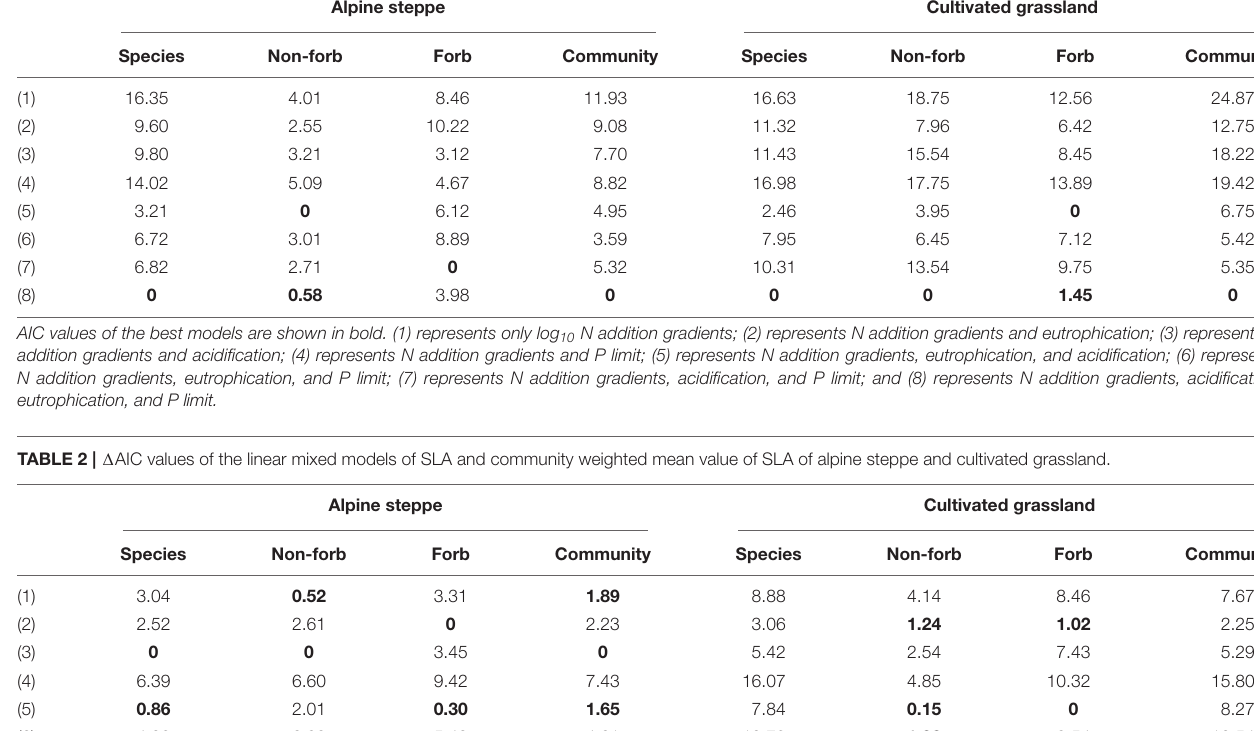
TABLE 1 | (cid:49) AIC values of the linear mixed models of plant height and community weighted mean value of height in alpine steppe and cultivated grassland. Alpine steppe Cultivated grassland Species Non-forb Forb Community Species Non-forb Forb Community